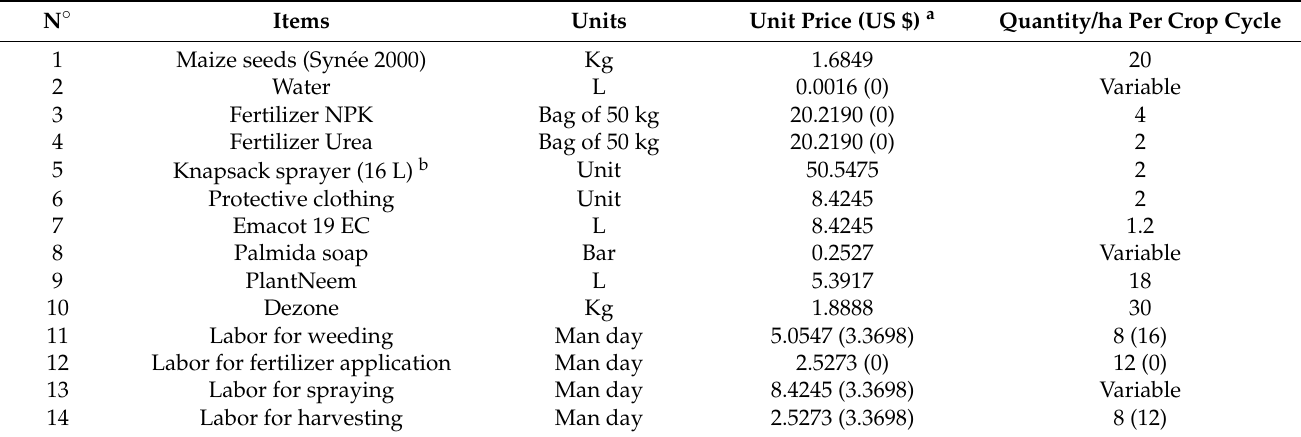
Table 2. Costs of required items in maize production.